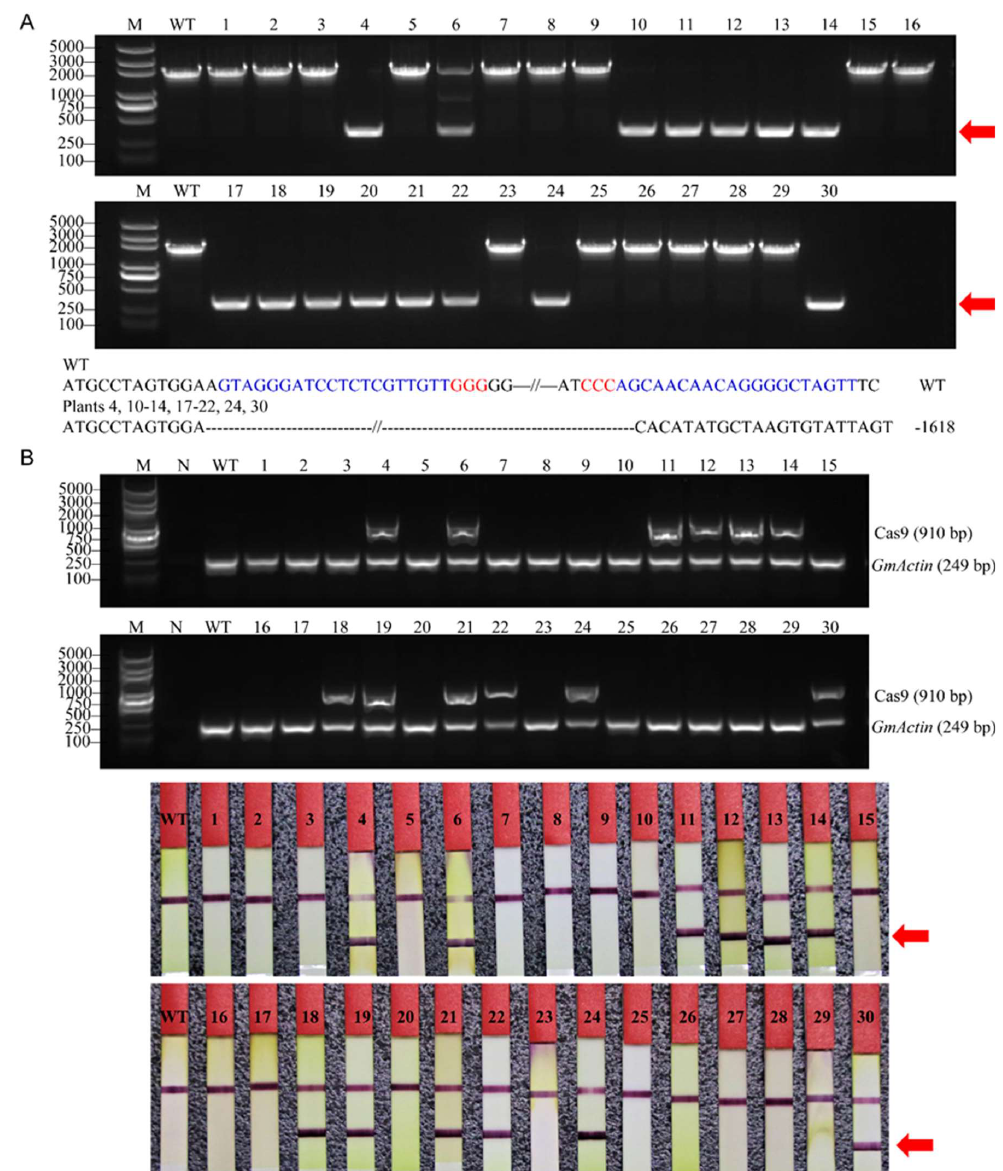
Figure 3. Large fragment deletion mutations induced in T0- GmFT2a -D1/D2-#32 lines were transmitted to the T1 generation. ( A ) M, DL2000 ladder DNA marker; WT, wild type; dash, base deletion. Red arrowheads indicate the lines which were subsequently sequenced. Plants 4, 10–14, 17–22, 24, and 30 were homozygous for large fragment deletion mutations, and all homozygous fragment deletion mutations were 1618 bp. ( B ) Identifying ‘transgene-free’ plants. Upper part, gel image of PCR products. Cas9 (910 bp), part of the Cas9 coding sequence. GmActin was used as an internal control gene. M, DL2000 Plus ladder DNA marker. N, negative control (water as template). Bottom half, detection of the selectable marker gene bar by test strip. The bands at the red arrowhead indicate that bar is positive. WT, wild-type plant. Labels 1–30, individual plants of the T1 progeny of the T0- GmFT2a -D1/D2-#32 line. The T2 progeny of these three individuals (plants 10, 17, 20), wild-type plants (WT) and light/8 h dark) and short-day (SD, 12 h light/12 h dark) photoperiodic conditions. We